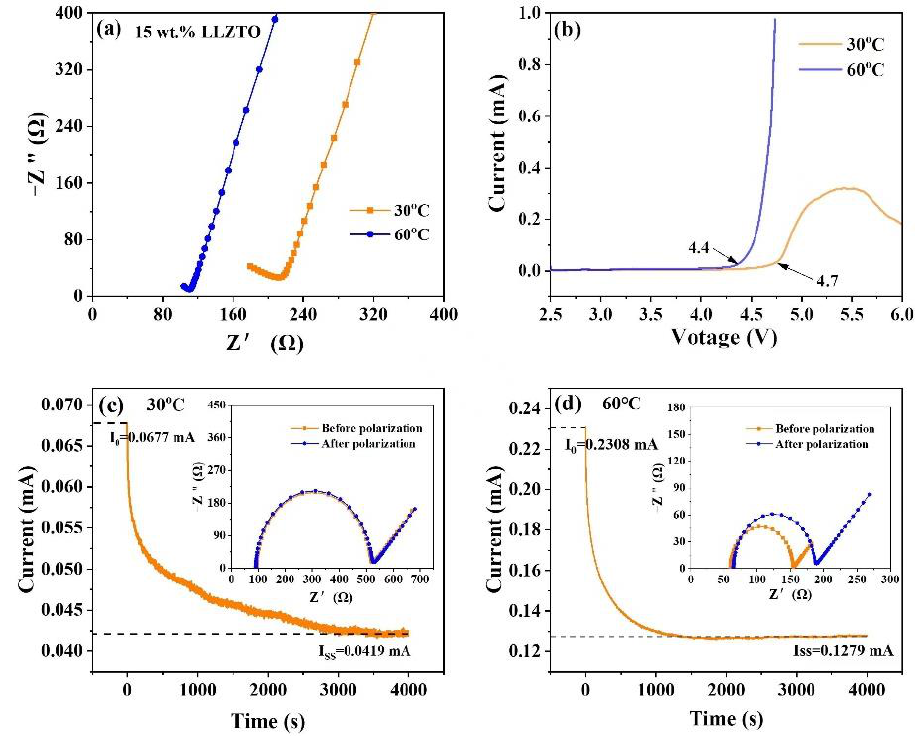
Figure 5. ( a ) Impedance diagram, ( b ) LSV diagram, and ( c , d ) DC polarization and AC impedance curves of CSE at 30 and 60 °C.